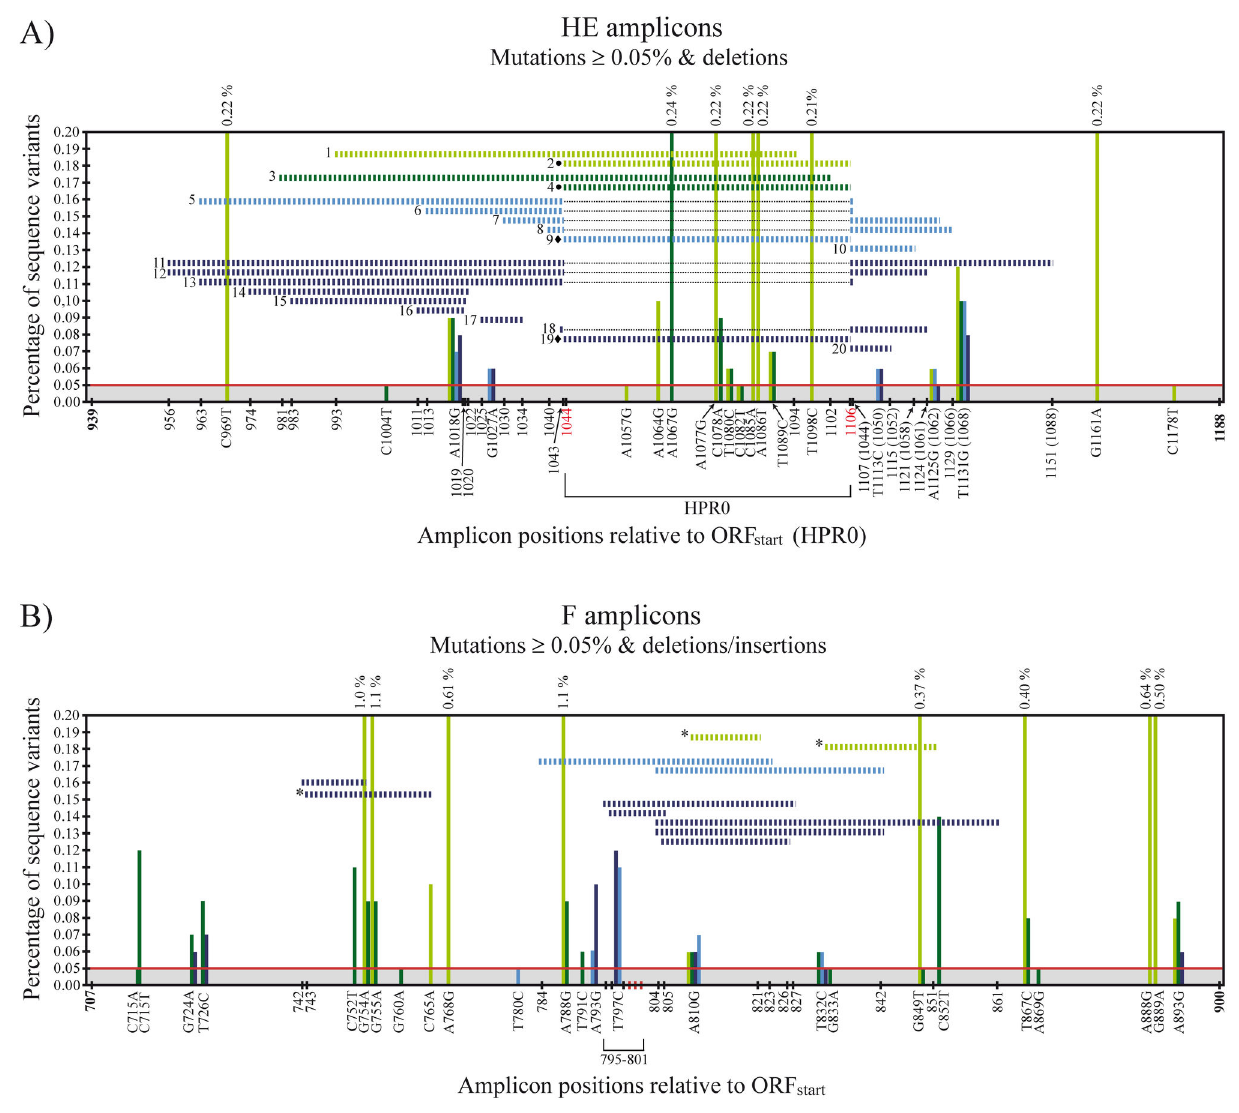
Figure 1. Position, percentage and type of single nucleotide variants (vertical lines), and deletion-insertions and deletions (horizontal lines) detected in reads from UDPS of HE gene (A) and F gene (B) amplicons from a non-virulent HPR0- and a virulent ISAV strain. Grey shading and the red horizontal line illustrate that only mutations present in frequencies ≥ 0.05 % are included. Color coding; light green = single screening sample, dark green = pooled screening sample, light blue = single outbreak sample, dark blue = pooled outbreak sample. The three red vertical lines in B) is the L /Q codon in the F gene. Numbering of 266 266 deletion events in A) correspond to numbering in Figures 2a, b . * = deletion-insertion types observed in F reads (regions deleted are shown, see Table S3 for details), • = outbreak delHPRs in screening samples, and♦ = full-length HPRs in outbreak samples. Numbers in bold indicate ORF and ORF positions in HPRO HE- and F genes not containing insertions. Red numbers indicate start end start and end of the full-length HPR, and numbers in parenthesis downstream of this region are the corresponding positions relative ORF in the outbreak delHPR. Dotted lines illustrate the full-length HPR portion not present in the delHPR. start doi: 10.1371/journal.pone.0081571.g001 former folds into a structure with less basepairing (i.e. “HPR0 Regions flanking the delHPR T -C site but not the 1043 1044 RNA motif”) compared to a single hairpin motif predicted to be full-length HPR are predicted to fold into a RNA hairpin formed by sequences flanking the T -C site in the latter motif. The lowest free energy predicted (+)RNA secondary 1043 1044 (Figures 2a, b ). These two motifs, displayed only when the structures for the Sanger sequences of the HE amplicons from predictions were run in the sense (+) orientation, were screening and outbreak suggests that the full-length HPR in the